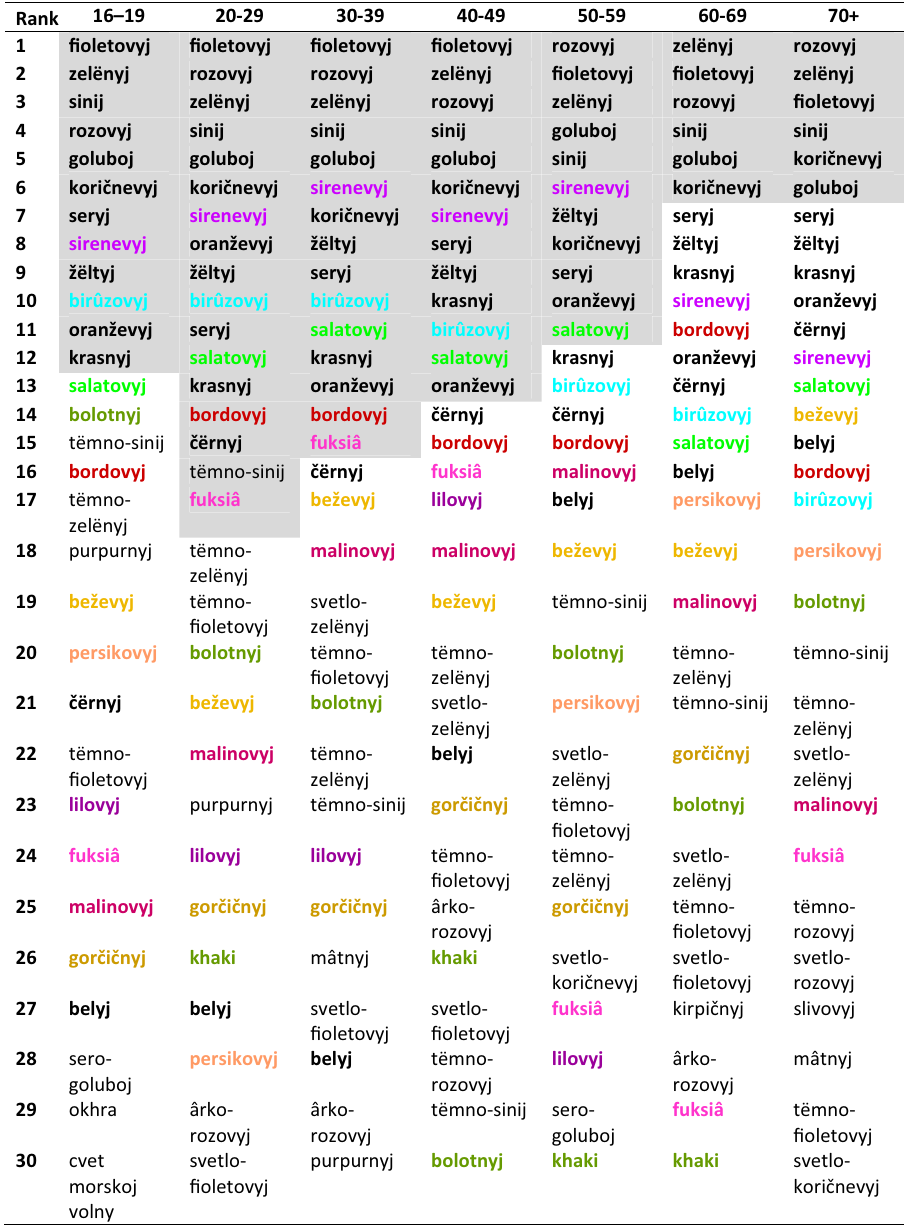
Table 3 The fi rst 30 most frequent color names elicited in individual age groups.